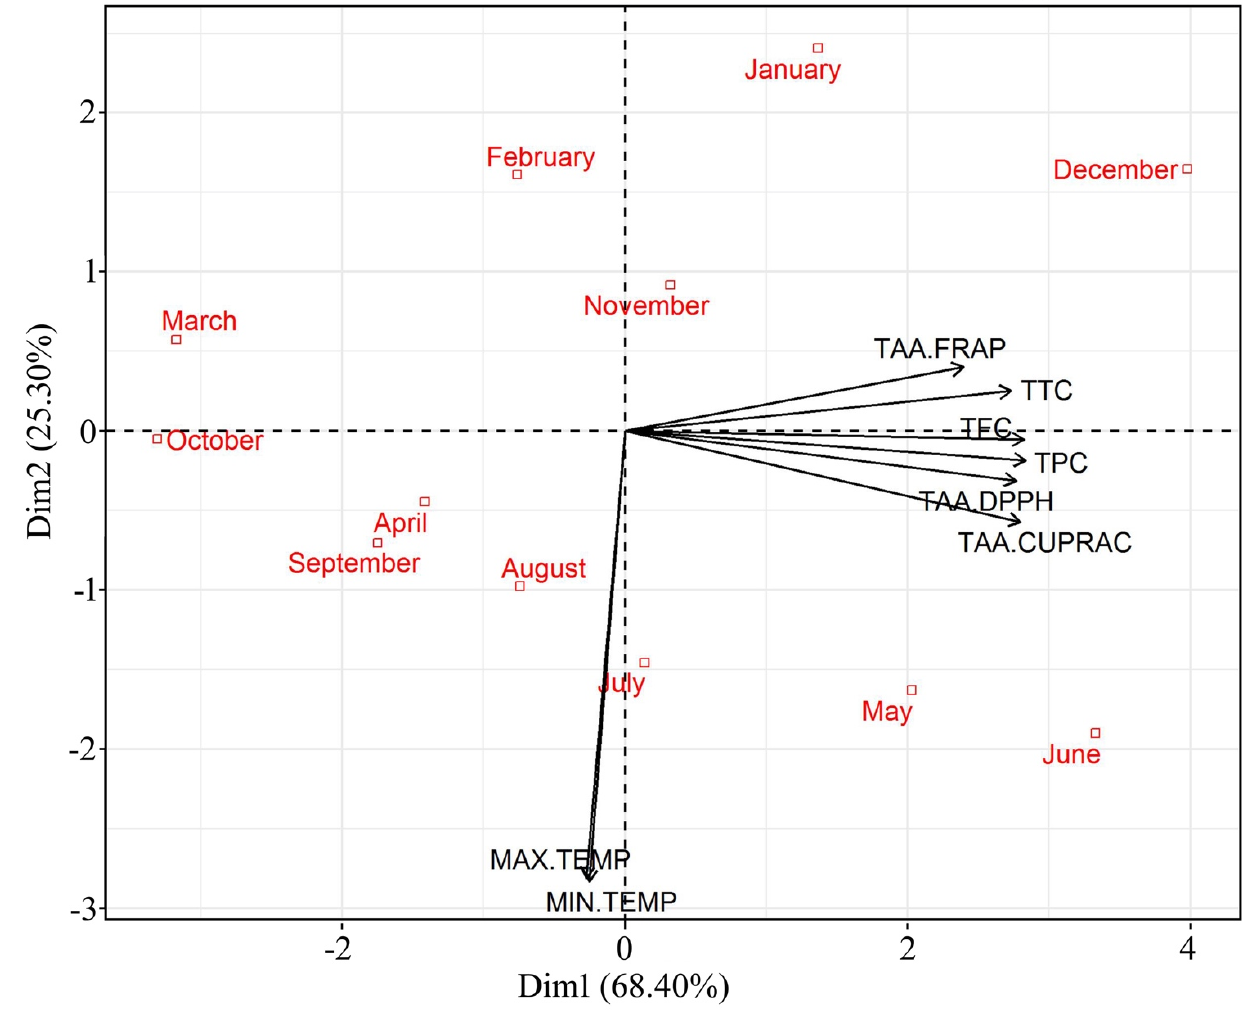
Figure 3. Principal component analysis (PCA) of TAA, phenolics, flavonoids, and tanning content in C. polygonoides foliage during different months.